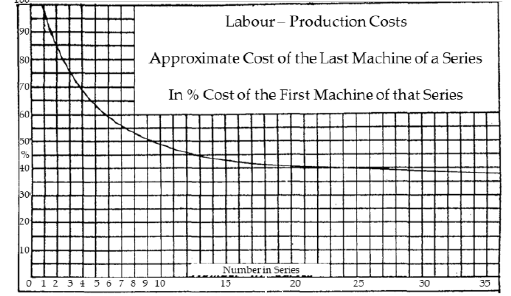
Figure 1. Cumulative average learning model graphic [10]. Figure 1. Unit learning model graphic